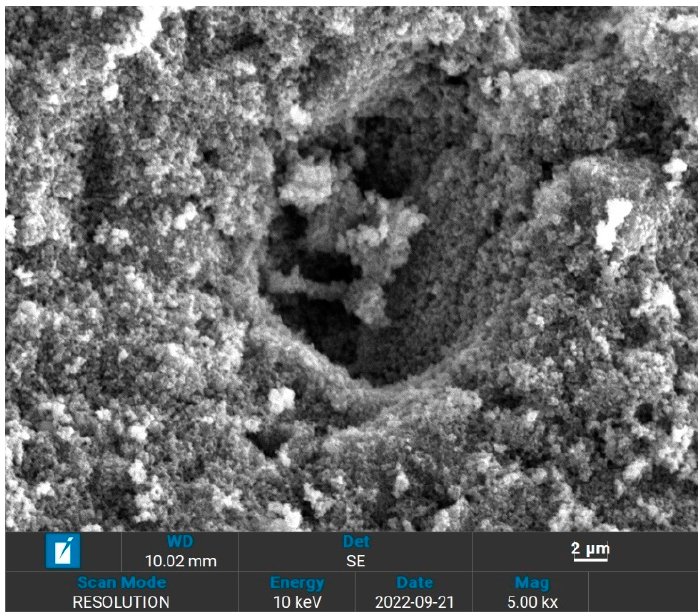
Figure 2. The surface of the pristine UiO-66 at 2 µm with magnification.